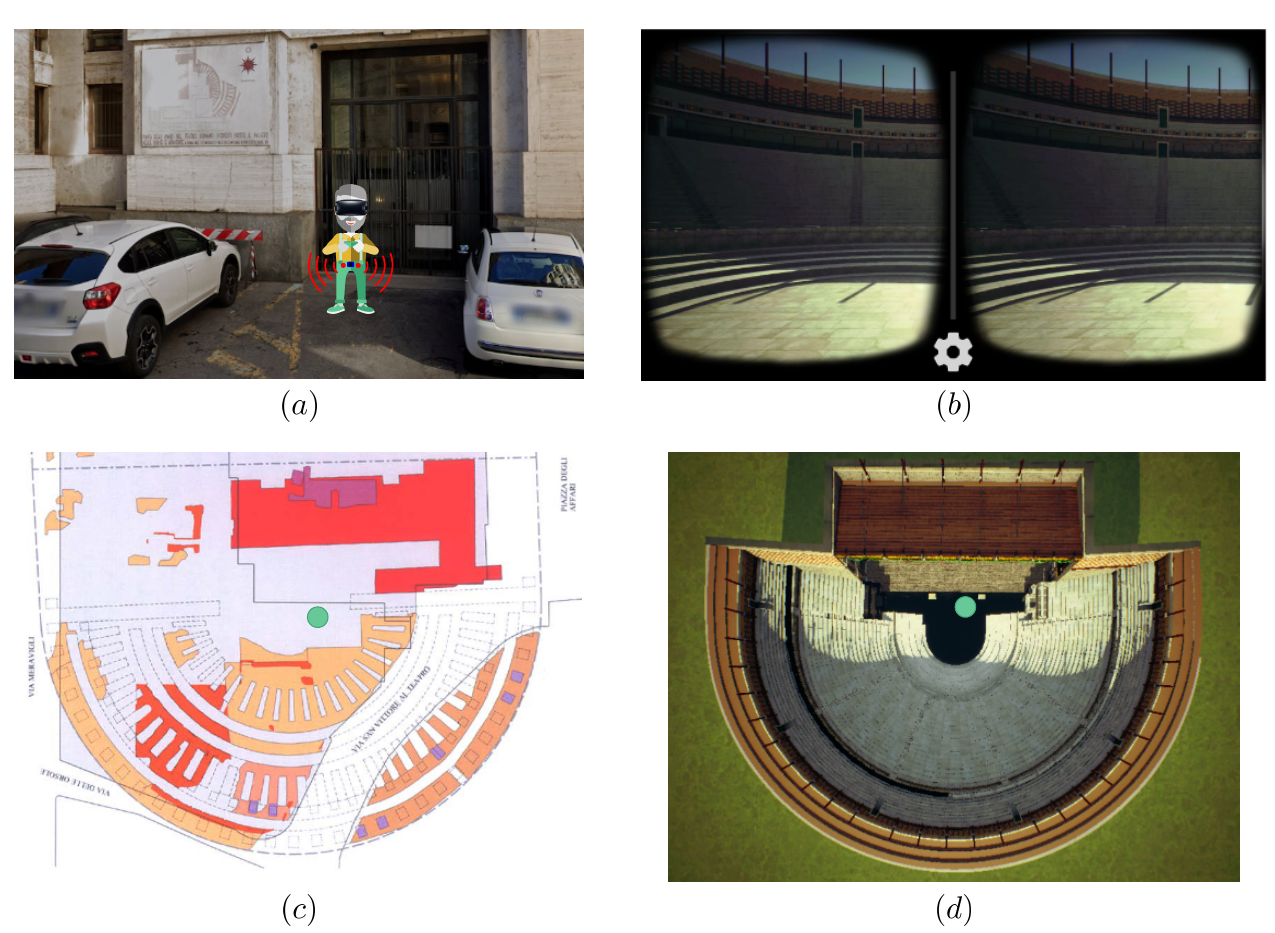
Figure 26. Tourism 4.0 application scenario. ( a ) End user in the real world, with IoT ultrasonic sensor perceiving the environment. ( b ) XR representation processed by the 5G MEC, and returned and showed to the end user inside his/her VR visor. ( c ) Two-dimensional (top view) map representation of the scenario, with a green marker representing the end user position. ( d ) Three-dimensional (top view) representation of the scenario, with a green marker representing the end user